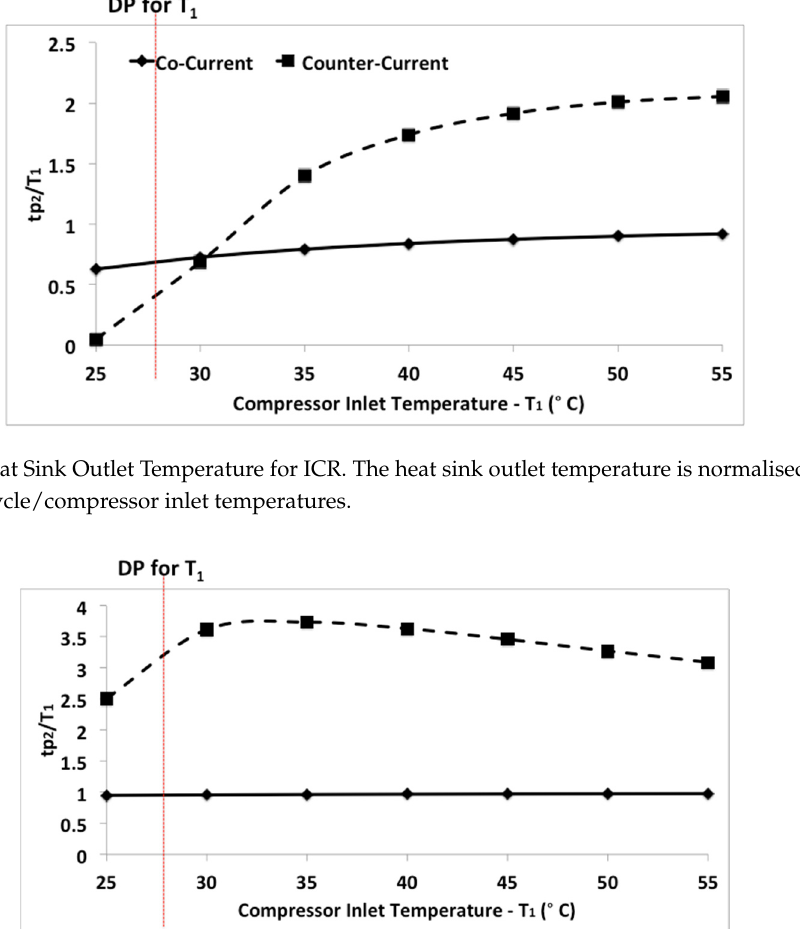
Figure 7. Heat Sink Outlet Temperature for SCR. The heat sink outlet temperature is normalised by the respective cycle/compressor inlet temperatures.